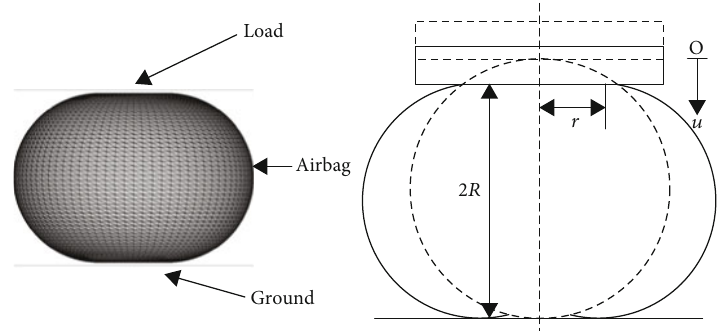
Figure 1: Schematic diagram of geometric changes in the spherical airbag cushioning